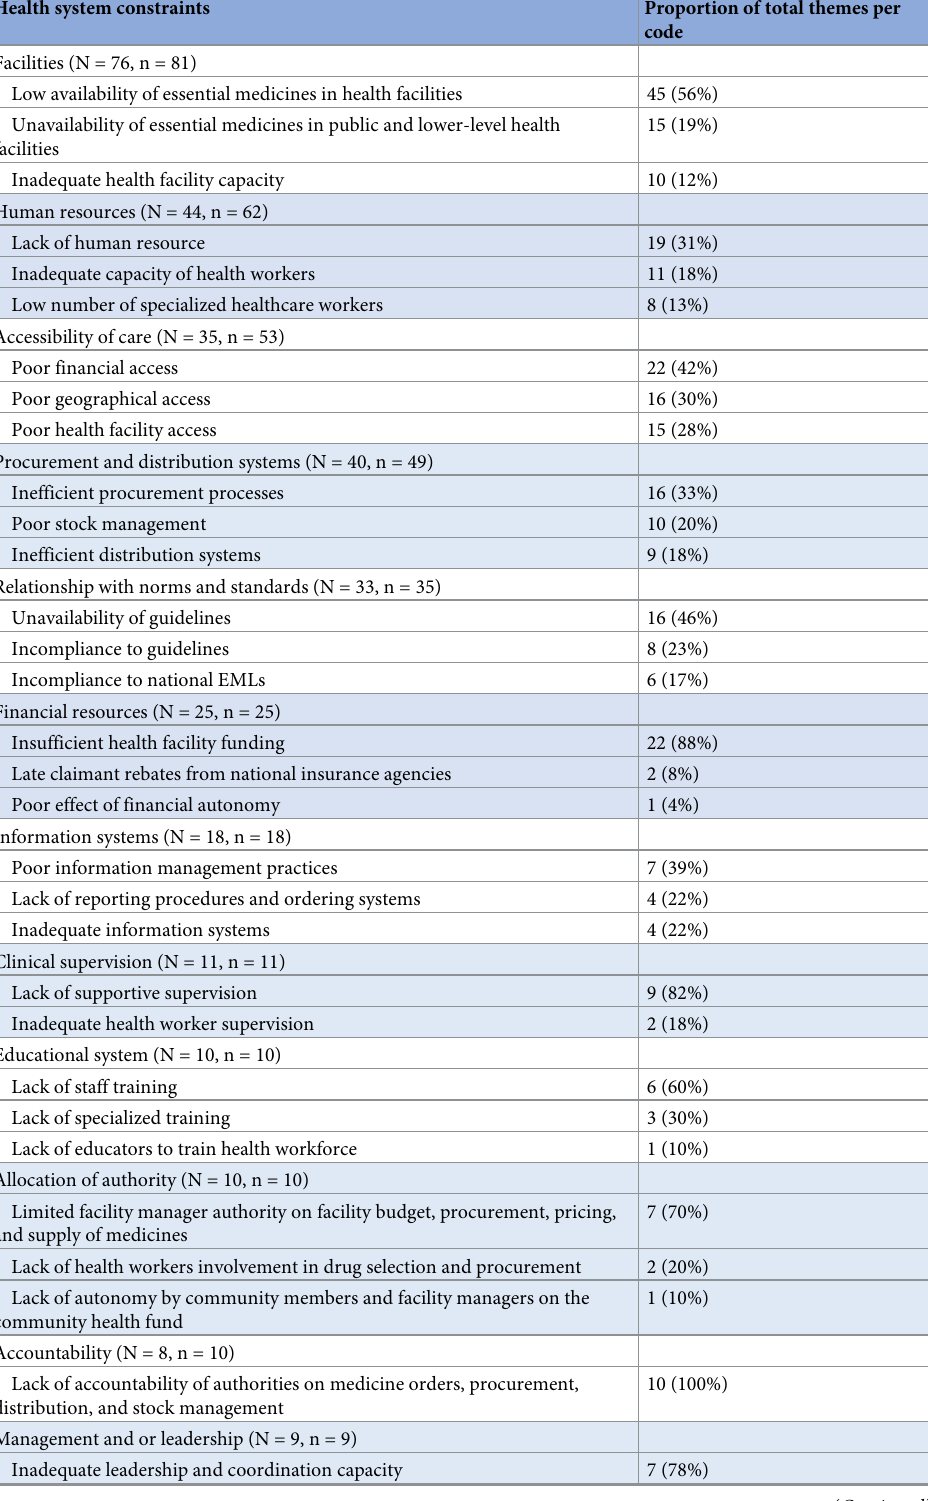
Table 4. Thematic content analysis of the most applied SURE codes to barriers to the implementation of